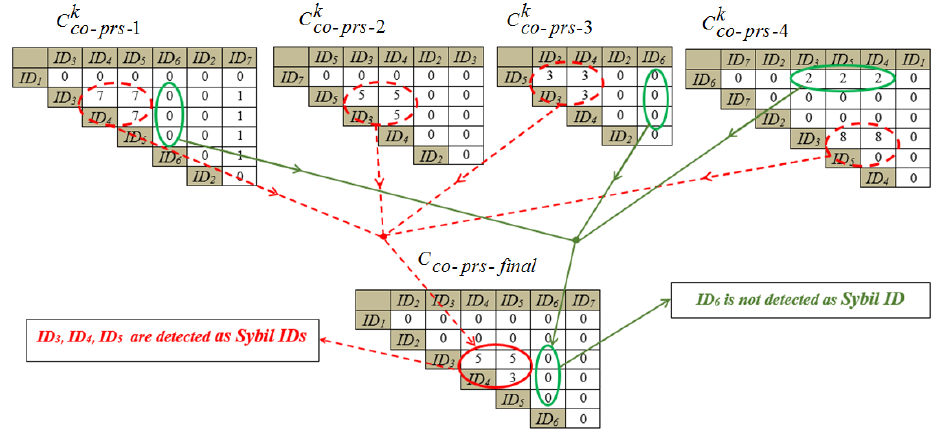
Figure 6. A pictorial representation of the advancement of the detection phase (Sybil IDs announcement) in the designated WD which is selected from W 1 − W 4